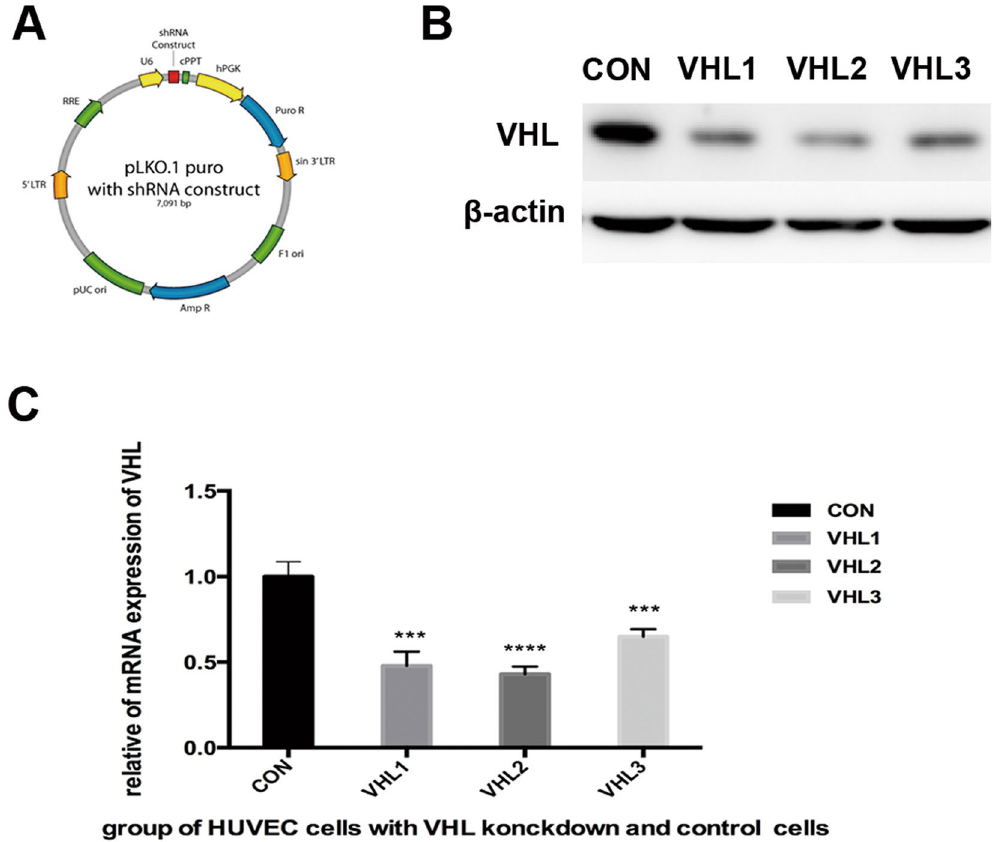
Figure 1. Knockdown of VHL gene expression in HUVEC cells by shRNA. The graph illustrated the schematic information of lentivirus vector pLKO.1 puro used for VHL shRNA construction ( A ). Western blot analysis ( B ) and qRT-PCR( C ) analysis evaluated the knockdown efficiency of VHL gene in HUVEC cells 72 h after transduction. Statistical analysis was performed using unpaired Student’s t test, *** represent P < 0.001, **** represent P < 0.0001. The original figure of western blotting was shown in Supplementary Figure